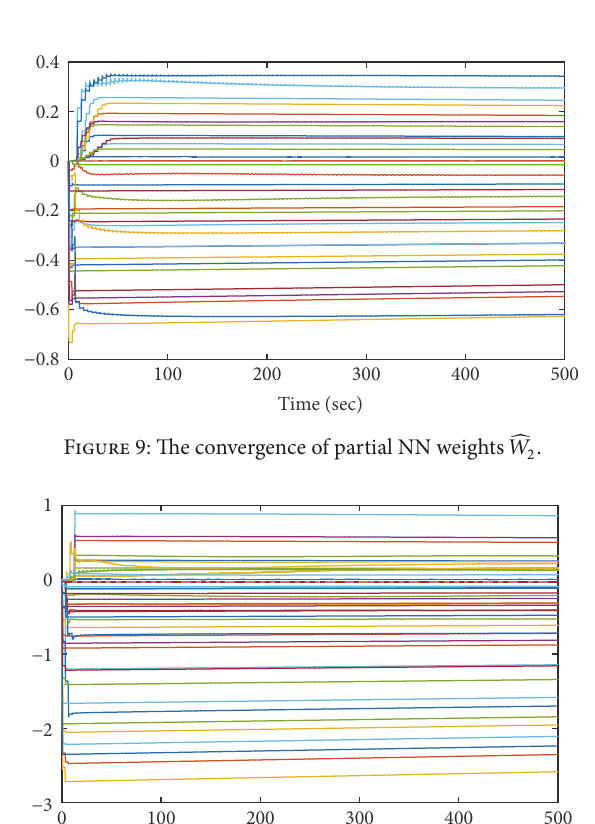
Figure 8: Function approximation: 2, 4 ).